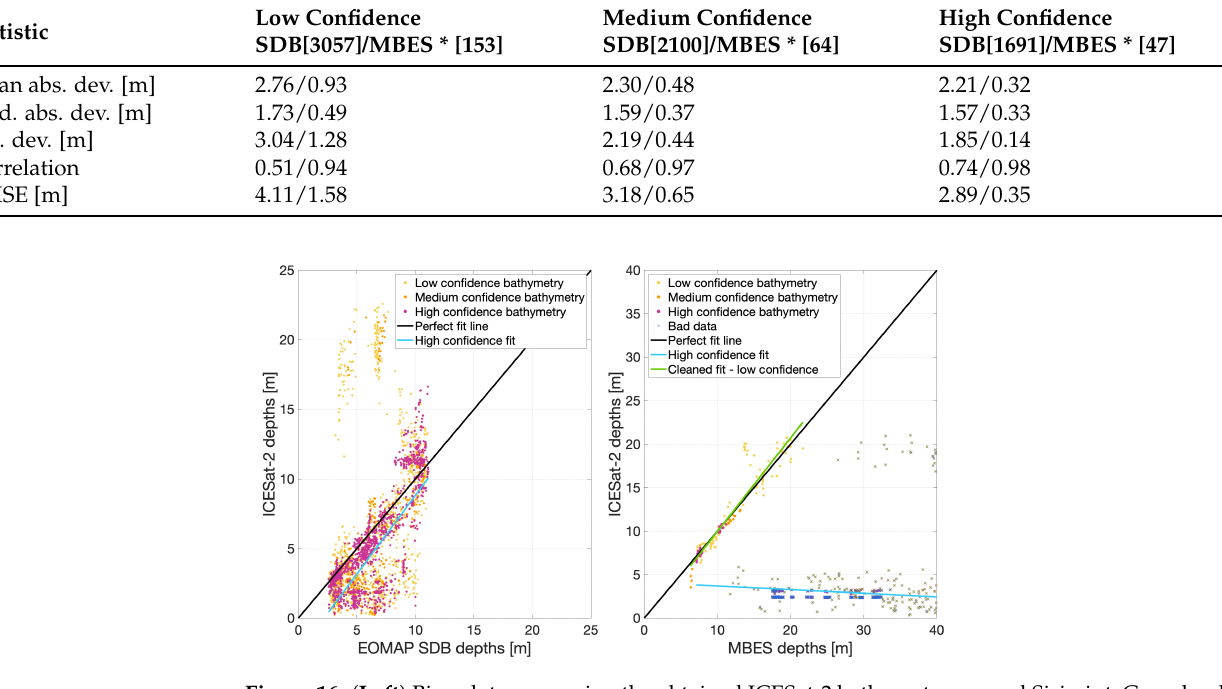
Figure 16. ( Left ) Bias plots comparing the obtained ICESat-2 bathymetry around Sisimiut, Greenland with bathymetry from EOMAP SDB and ( Right ) MBES. Depths are metres below the